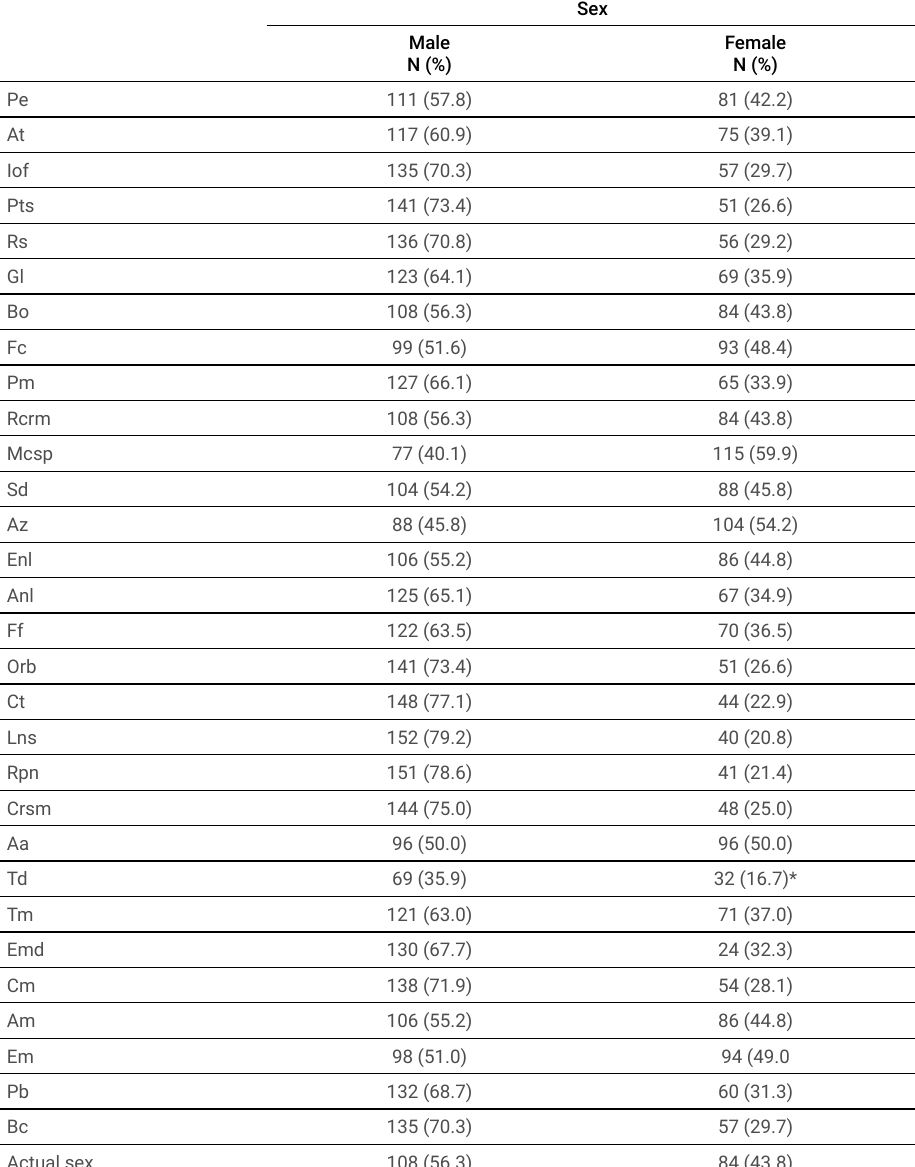
Table 3. Frequency and percentage of sex classification based on a subjective rater analysis of different